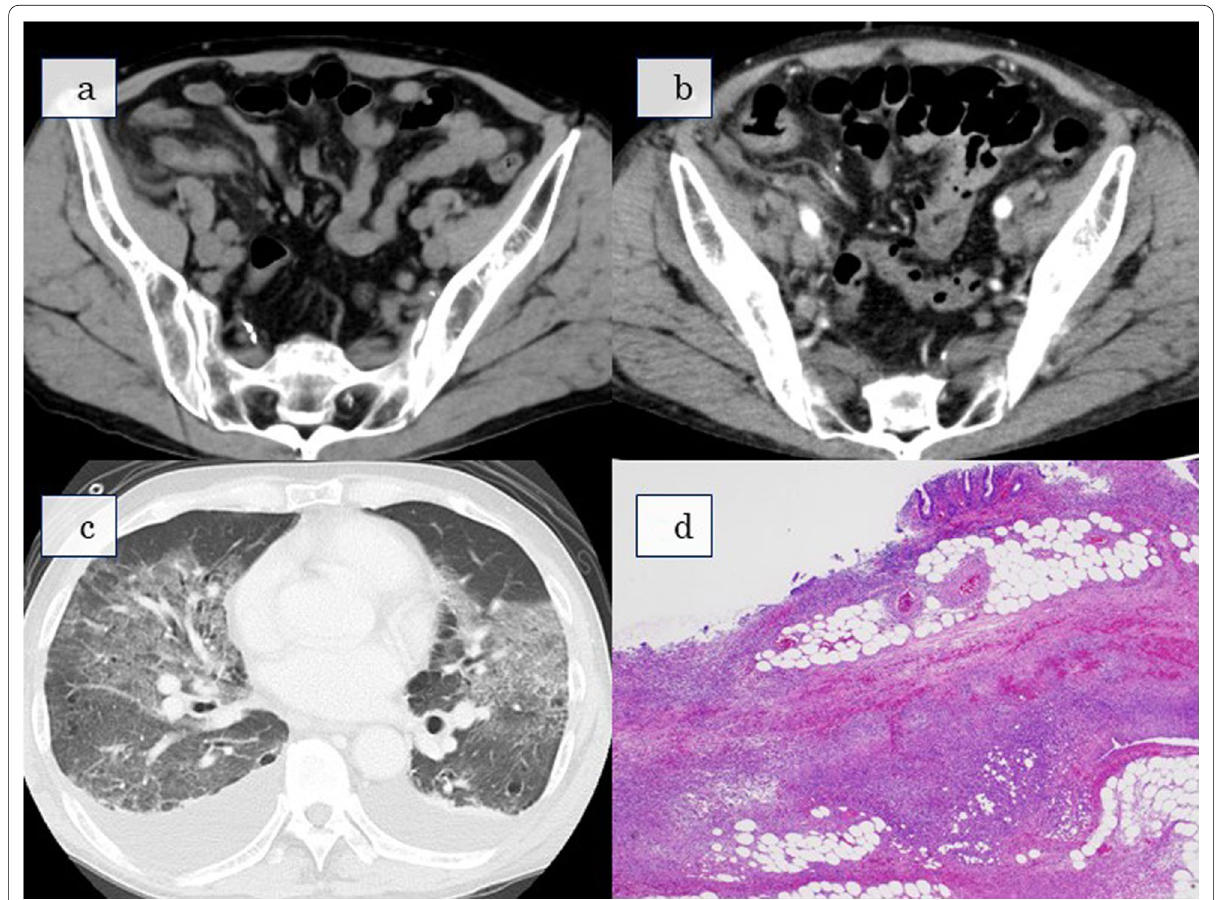
Fig. 1 a Abdominal CT at initial examination: CT reveals an enlarged appendix in the right lower abdomen. b Abdominal CT on postoperative day 3: there is no fluid accumulation suspicious of leakage at the edge of the dissection. c Chest CT on postoperative day 3: CT reveals bilateral pleural effusion and extensive mottled frosted glass shadows in the bilateral lung fields. d Histopathological analysis: the pathological diagnosis of the resected appendix is gangrenous appendicitis. CT Computed